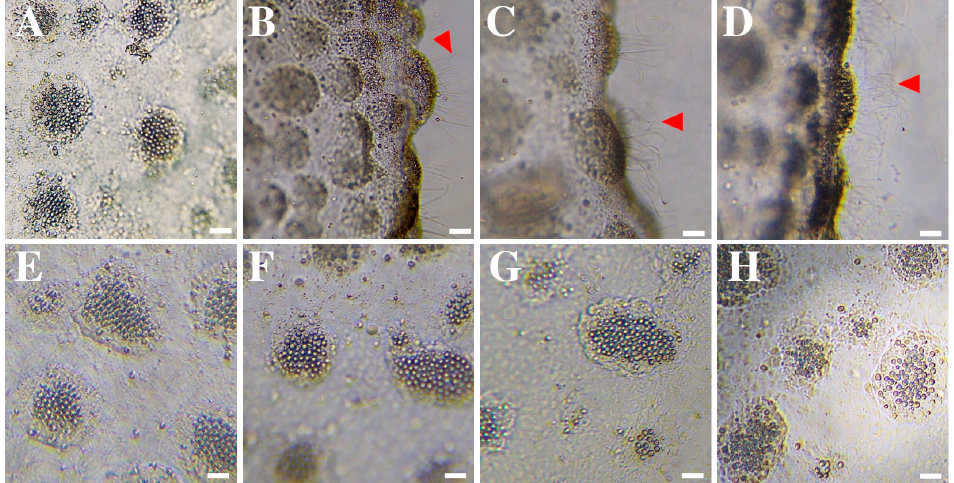
Figure 1. Nematocyst response of Rhizostoma pulmo after the application of ( A ) seawater (control),